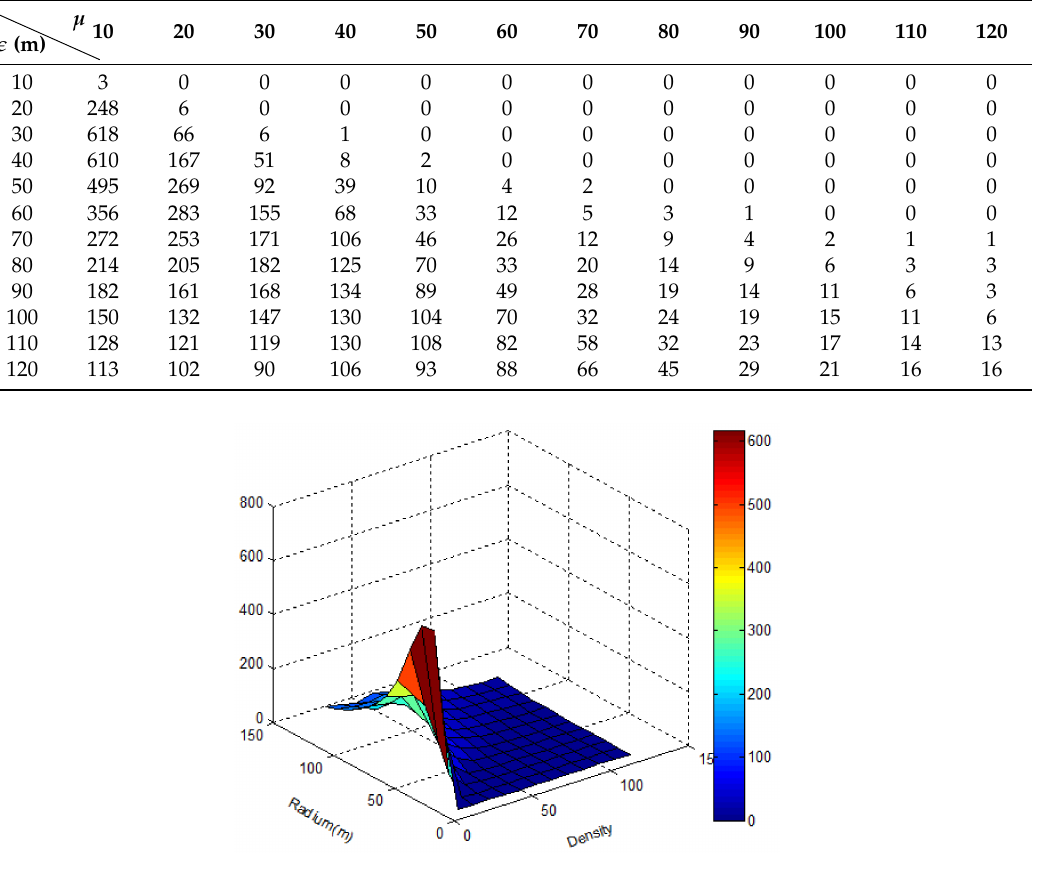
Figure 5. The clustering as a function of (cid:101) -radius and µ -density